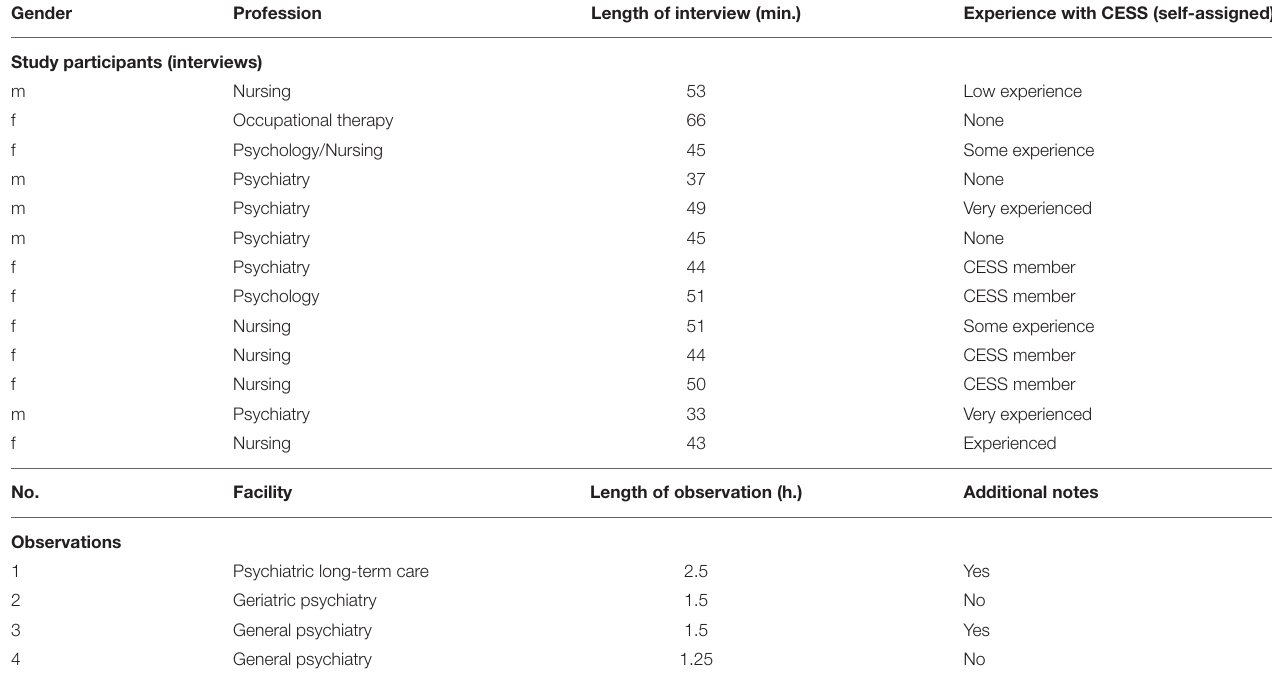
TABLE 1 | Overview of data material. Gender Profession Length of interview (min.) Experience with CESS